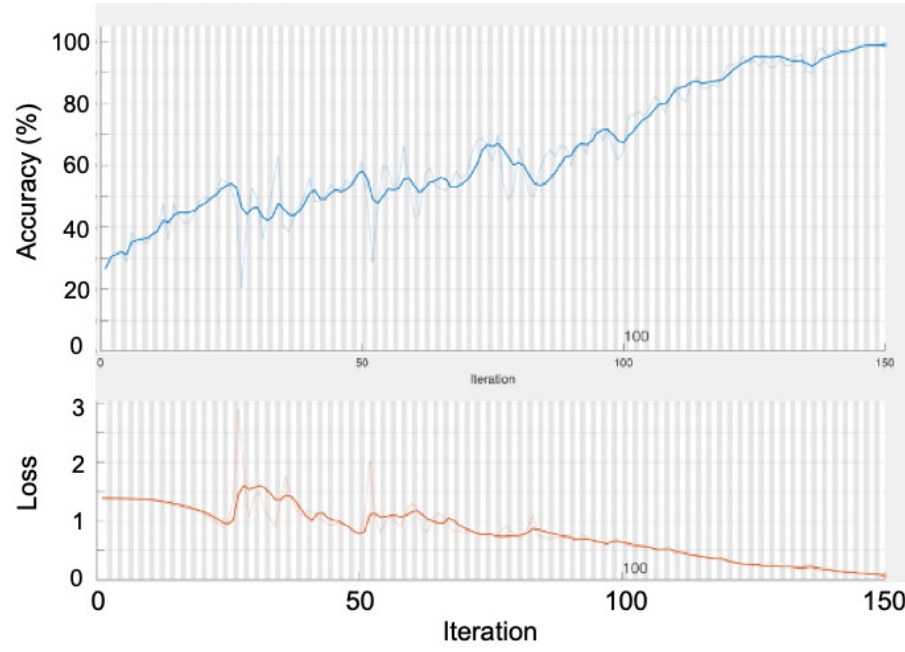
Figure 7. Performance of LSTM algorithm ( top ) Accuracy versus iteration and ( bottom ) Loss versus